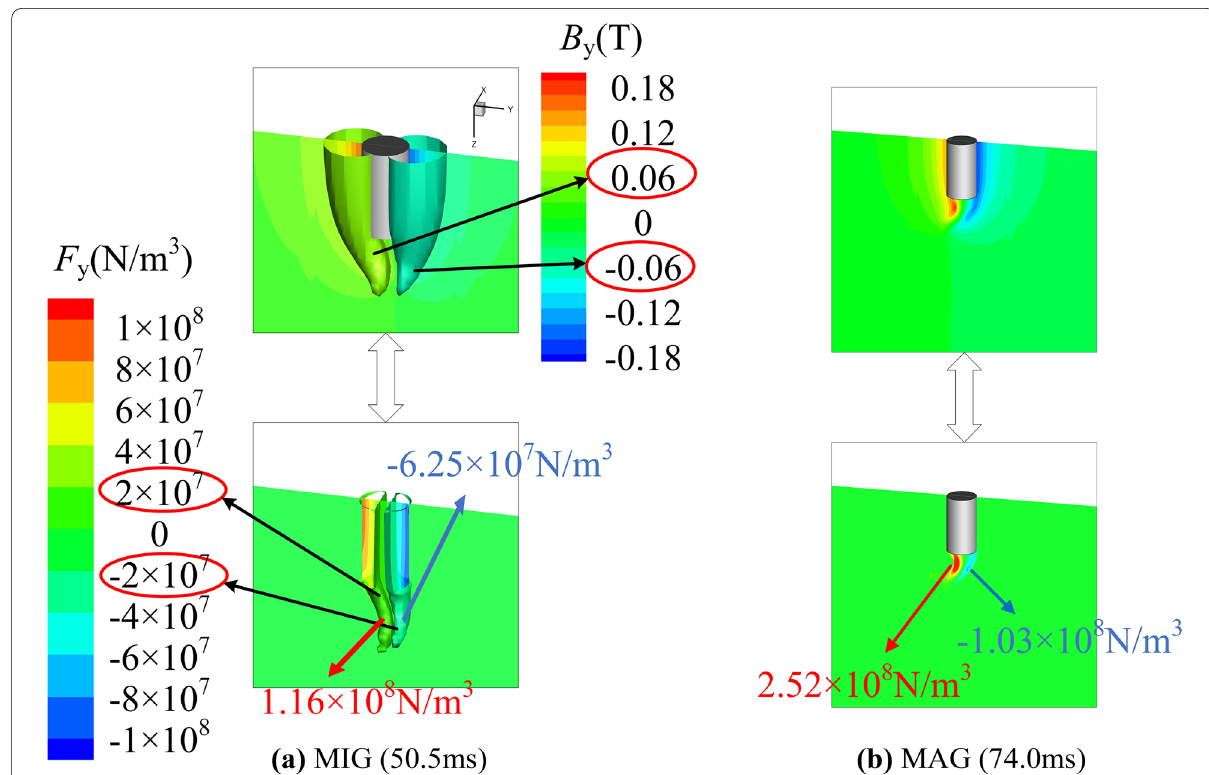
Figure 6 Magnetic flux density and electromagnetic force distributions in the y -direction of 500 A MIG and MAG